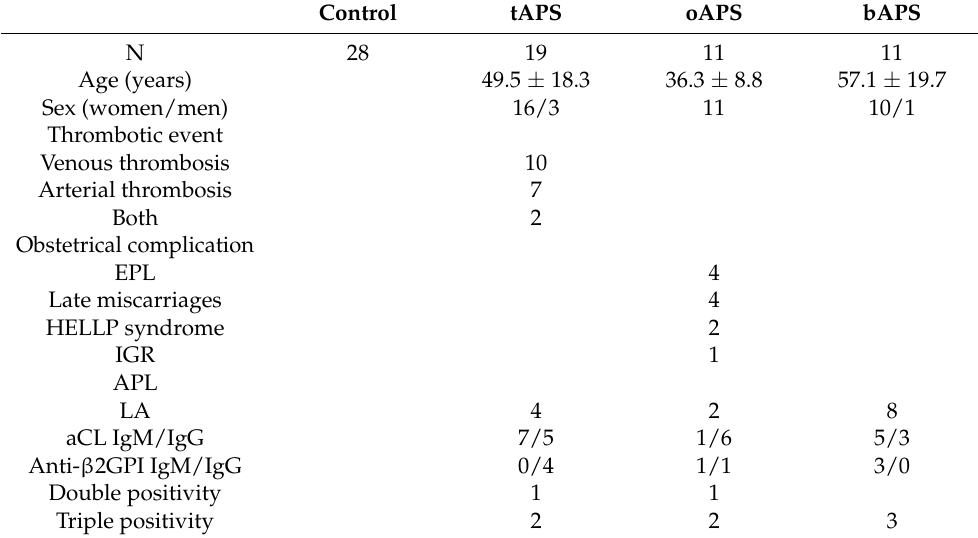
Table 1. Clinical and biological characteristics of patients. tAPS: thrombotic antiphospholipid syn- drome. oAPS: obstetrical antiphospholipid syndrome. bAPS: biological antiphospholipid syndrome. EPL: early pregnancy losses. IGR: placental insufficiency with intrauterine growth retardation. APL: antiphospholipid antibodies. LA: lupus anticoagulant. aCL: anticardiolipine. Anti- β 2GPI: anti-beta-2-glycoprotein